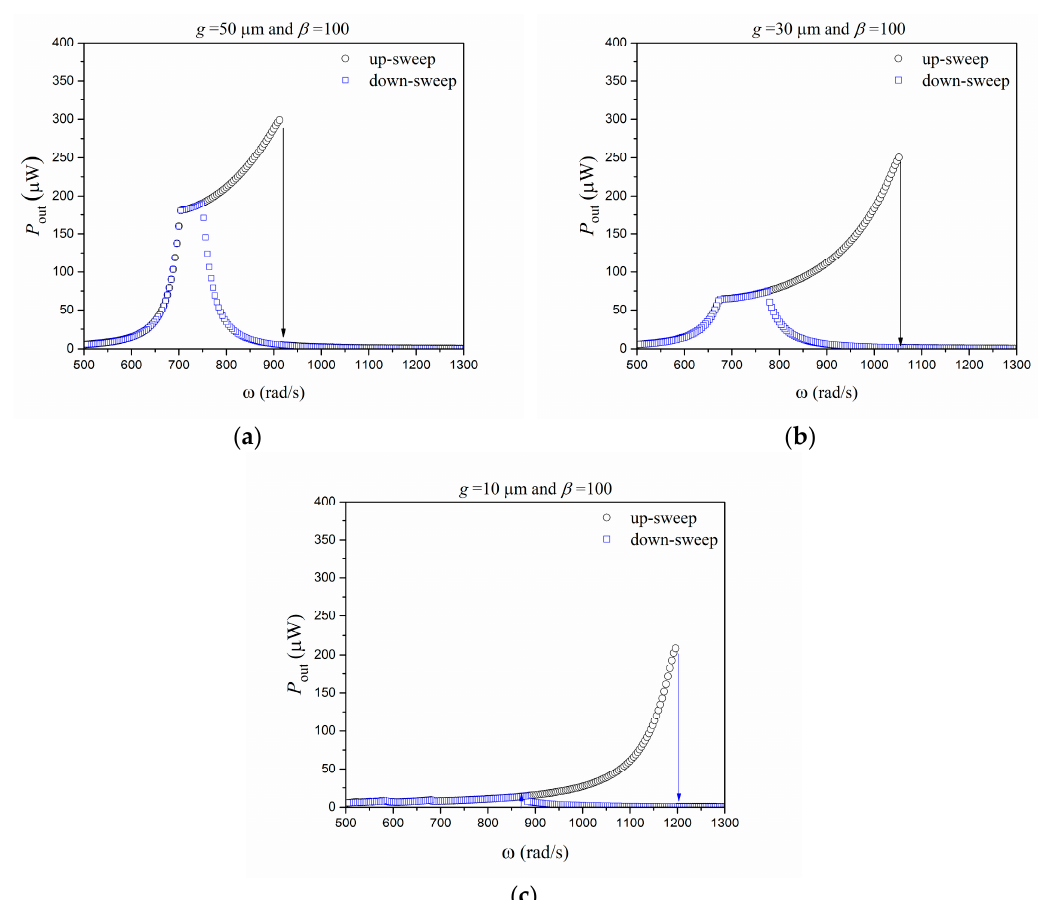
Figure 7. Dynamical jumps of average power for frequency up-sweep and down-sweep assuming 𝛽 = 100 : ( a ) 𝑔 = 50 μ m, ( b ) 𝑔 = 30 μ m, and ( c ) 𝑔 = 10 μ m.